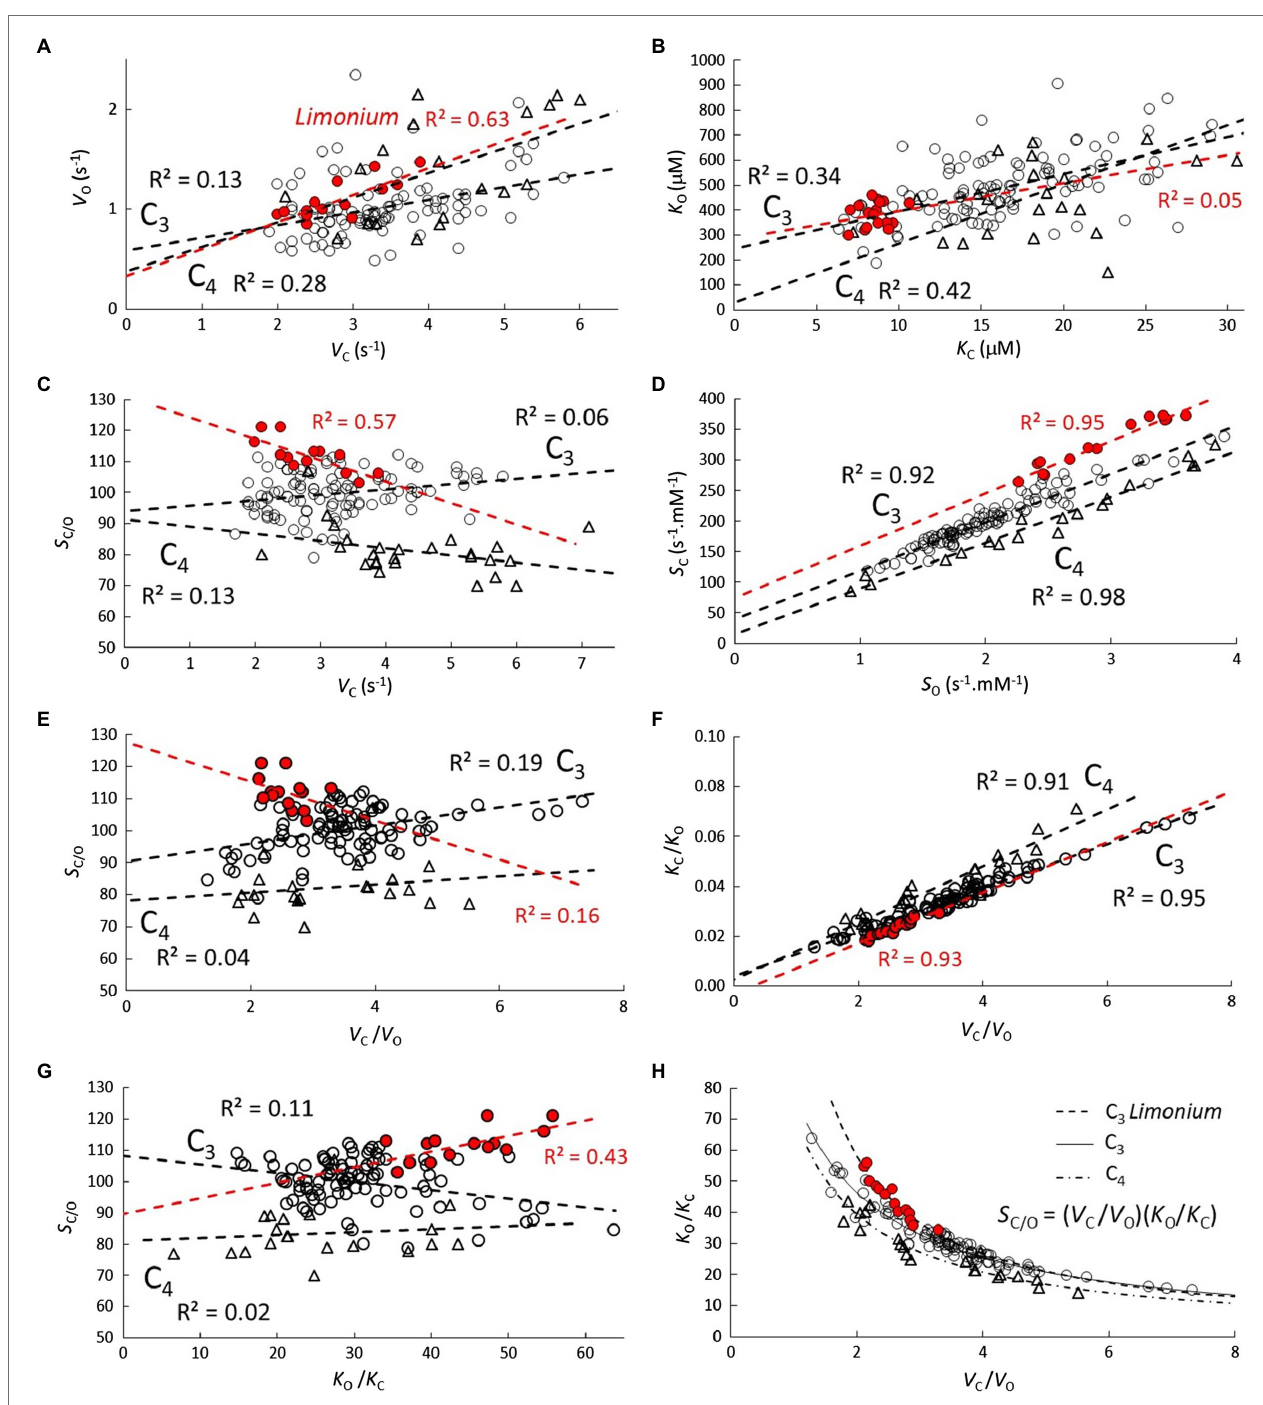
FIGURE 2 | Correlations (A-H) between carboxylase and oxygenase kinetic parameters. Scatter plots and lines of best fit with R 2 for C 3 ( ○ ), C 3 genus Limonium (highlighted in red), and C 4 ( ∆ ) plant RuBisCO